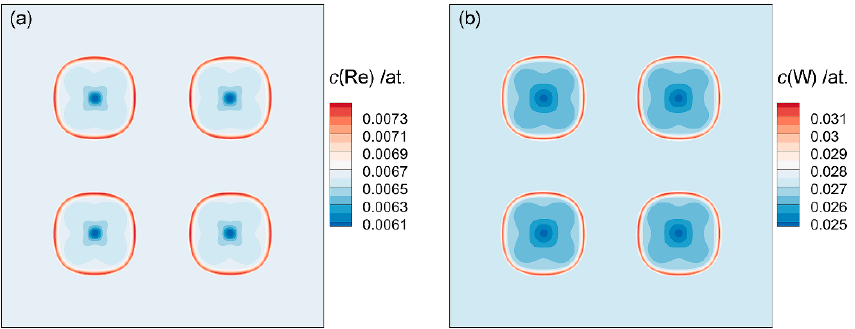
Figure 13. The distribution of Re ( a ) and W ( b ) element in DD6 superalloy after 1120 ◦ C / 2 h. Figure 12 depicted the distribution of chemical driving force. The chemical driving force